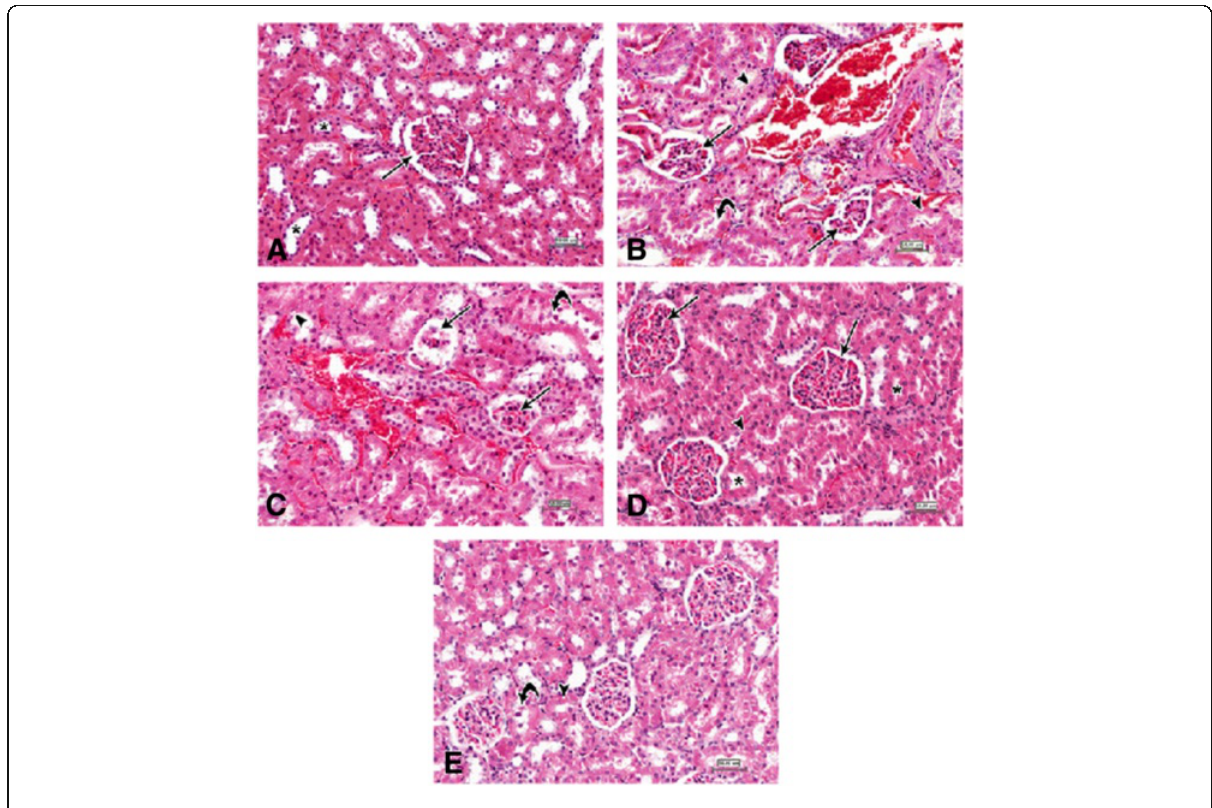
Figure 7 Photomicrographs of kidney sections from normal and intoxicated rats with 600 mg/kg body weight/day n-ZnO particles for 5 days stained with Masson trichrome (scale bars=50 μ m). All groups revealed normal distribution of a small amount of collagen fibers (arrow) between the renal tubules in the